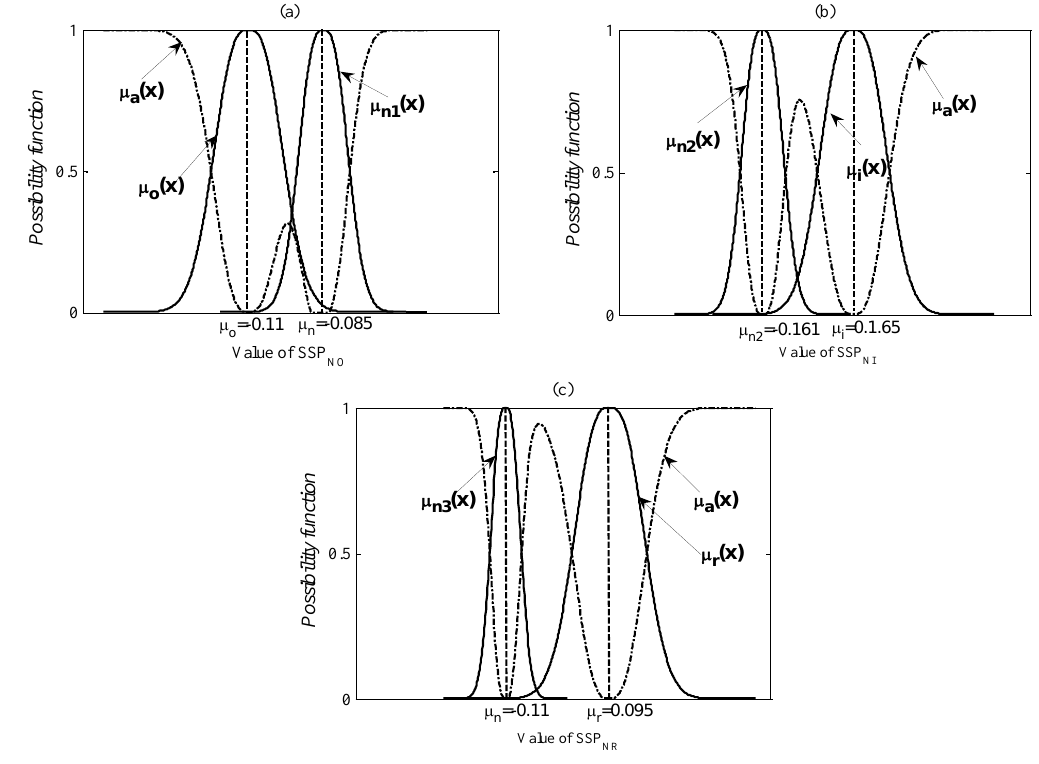
Figure 15. Membership functions for the first diagnostic